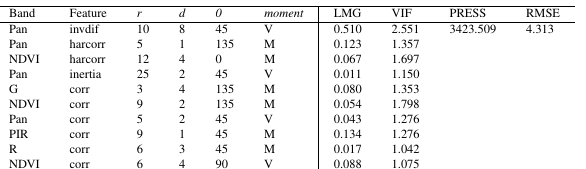
Figure 4: Cp’s curve for age features selection on the full dataset.The obtained variable subset is presented in Ta- ble 8 and the corresponding Cp’s curve in Figure 4. The optimal feature subset is not subject to multicollinearity, confirming the efficiency of the LARS subset selection. The predicted RMSE (obtained by leave-one-out validation) is 5.25 years, correspond- ing to 10% of the age dynamic over the site.